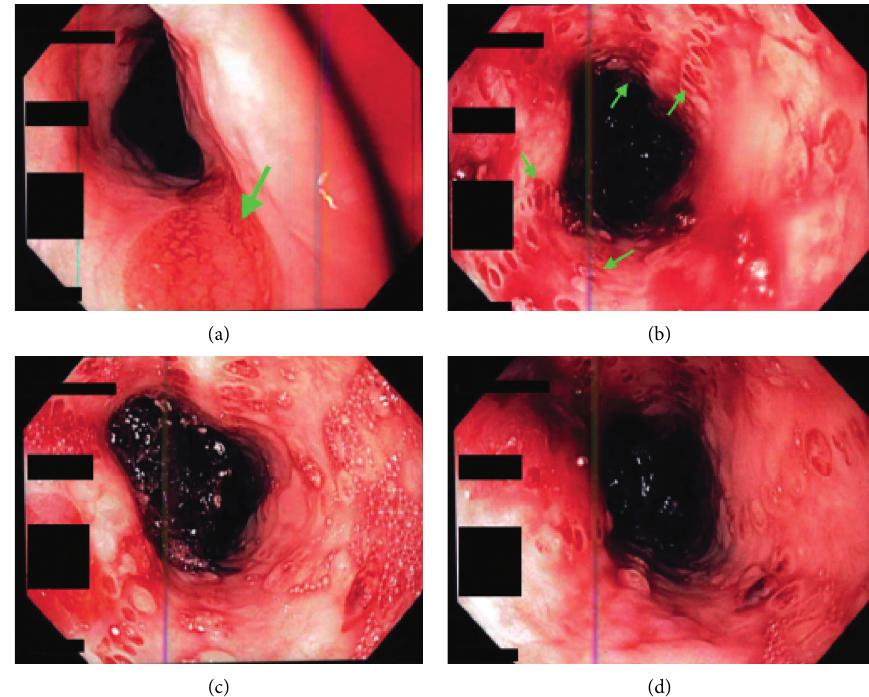
Figure 1: Upper endoscopic evaluation showing multiple mucosal ulcers with blisters throughout the esophagus suggestive of pemphigus